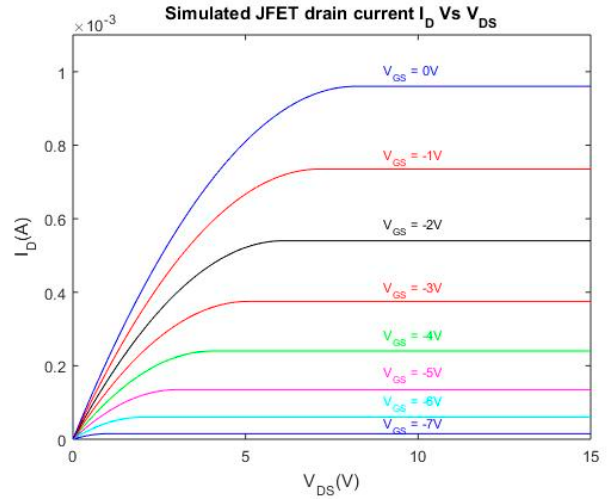
Figure 2. Simulated junction field effect transistor (JFET) drain characteristics.